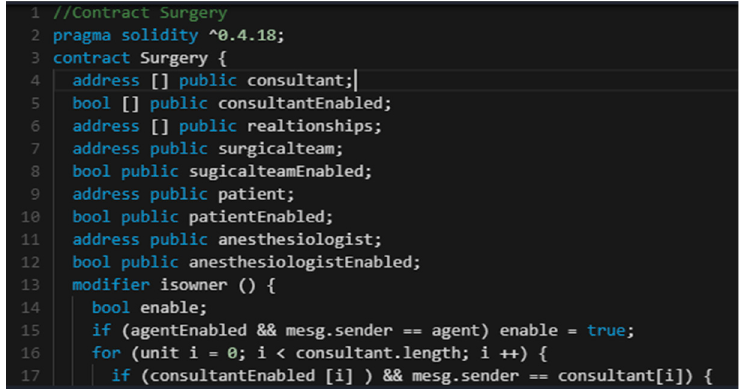
Figure 9. Contract surgery.